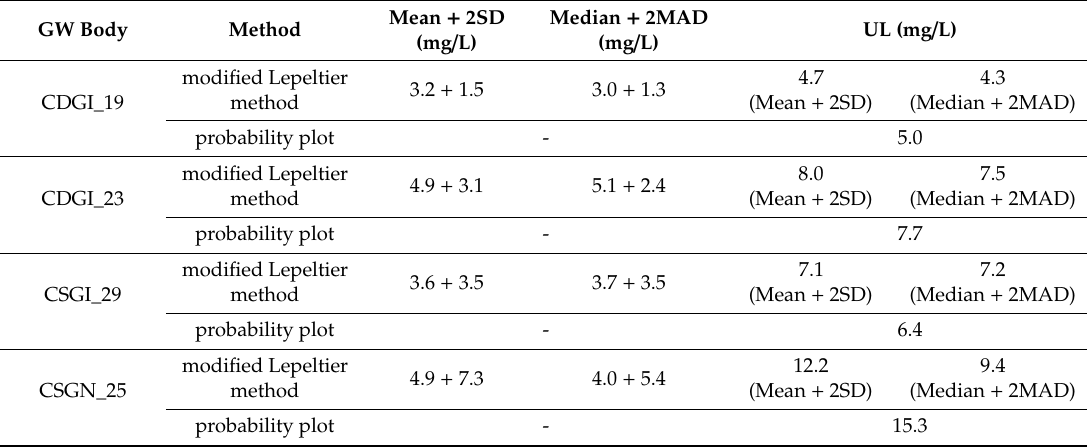
Table 7. Estimated Mean + 2SD and Median + 2MAD ranges (for modified Lepeltier method) and the upper limits of ranges of ambient background concentrations (UL) of chloride (Cl) obtained by selected methods. EU Drinking Water Standard for Cl is 250 mg /